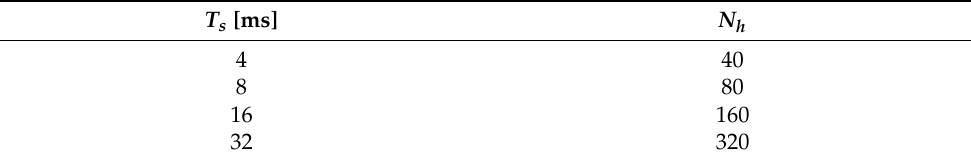
Table 8. Size of the coefficients vector depending on the signal duration.